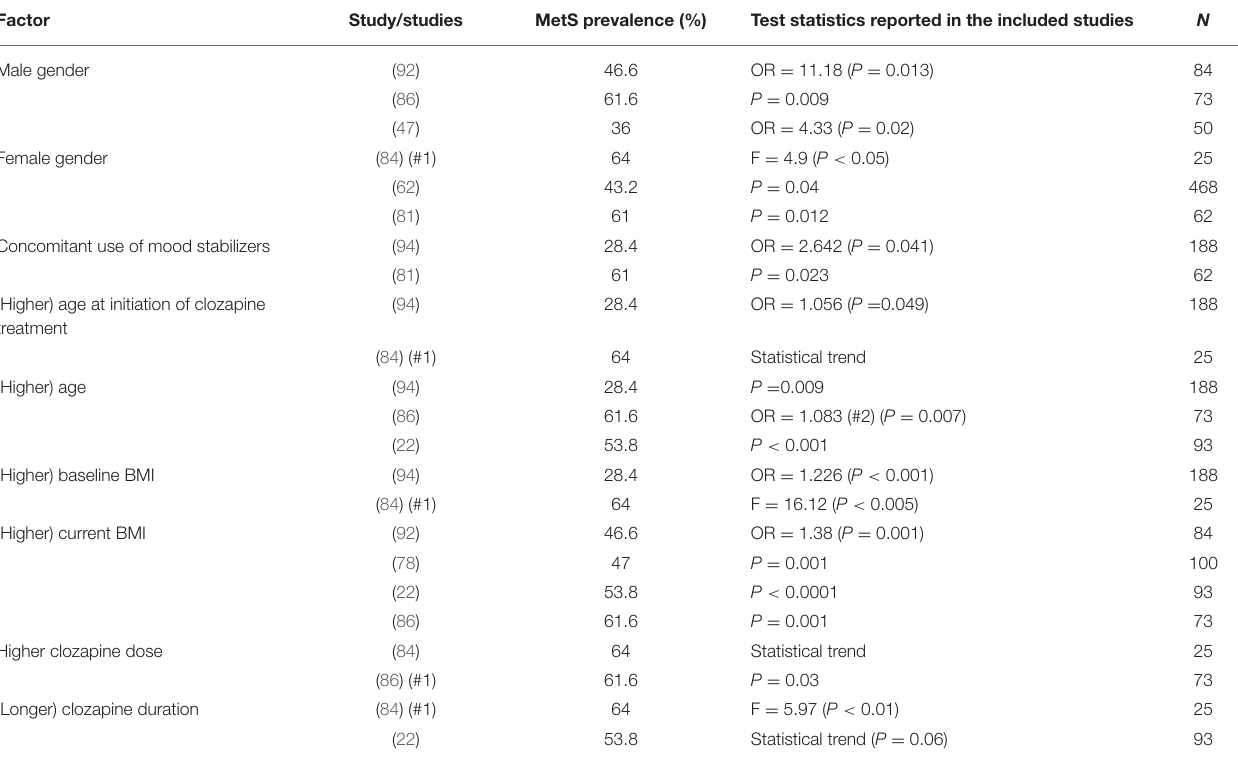
TABLE 2 | Factors associated with MetS in clozapine users reported by ≥ 2 studies.